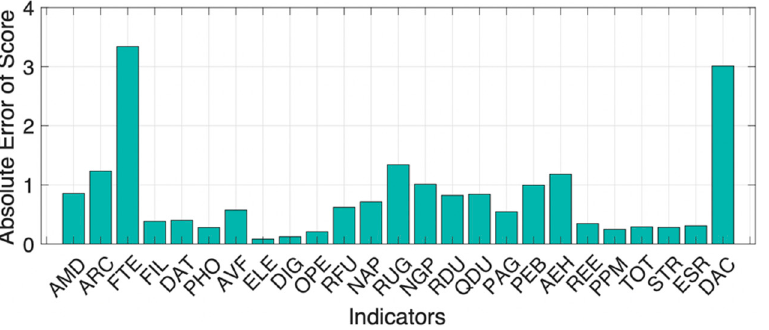
Figure 4. The average absolute difference in performance (scores) caused by the deletion of a particular indicator.